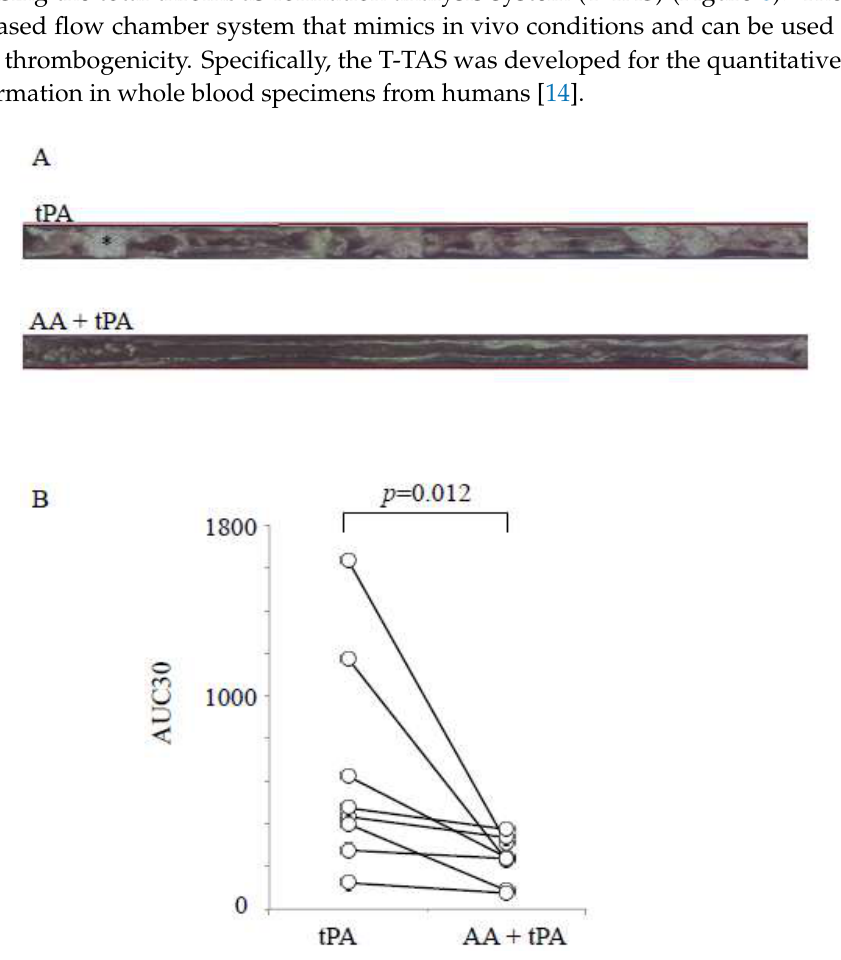
Figure 6. E ff ect of l -ascorbic acid on recombinant tissue-type plasminogen activator-induced fibrinolysis under flow conditions in human whole blood. ( A ) Representative video microscopy images of fibrinolysis over 18–19 min in samples exposed to recombinant tissue-type plasminogen activator (rtPA) or AA–tPA in human whole blood. The asterisk shows an example of thrombi (white area). ( B ) Area under the curve at 30 min (AUC30) following tPA treatment and AA and tPA treatment in human whole blood ( n = 8). Overall, the AUC30 was significantly lower following the AA and tPA treatment than the treatment of tPA alone. Values are mean ± SE. Comparisons between two groups were performed using Wilcoxon’s signed rank